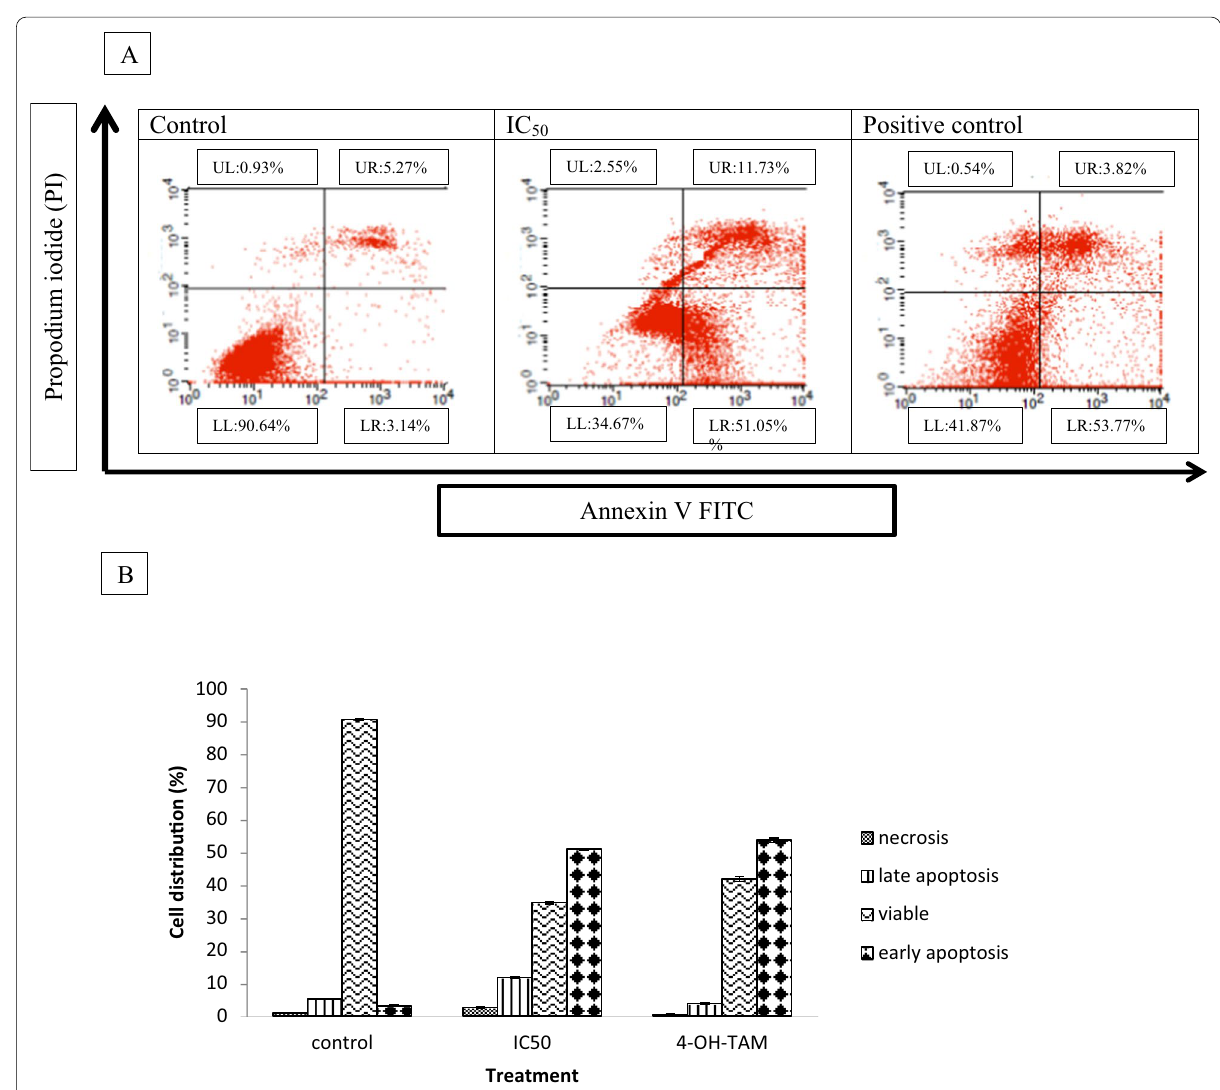
Fig. 7 Dot plots for flow cytometry analysis of the apoptosis effects MCF-7 cells treated with IC 50 CNDCM for 72 h. MCF-7 cells were exposed to vehicle control, IC 50 CNDCM and positive control. A Dot plots and B histogram for apoptosis analysis. A Quadrant location for the representative dot plots: UL (upper left)—FITC − /PT + (necrotic cells); UR (upper right)—FITC + /PI + (late apoptotic cells); LL (lower left)—FITC − /PI − (viable cells); LR (lower right)—FITC + /PI − (early apoptotic cells). B Percentage of cell distribution of MCF-7 cells as determined by annexin V-FITC and PI staining. Asterisks signify significance statistically at p < 0.05 compared to control (untreated MCF-7 cells) and positive control (4-OH-TAM). The percentage of the MCF-7 cell population was increased significantly for both IC50 of CNDCM extracts and positive control of treatment when compared with